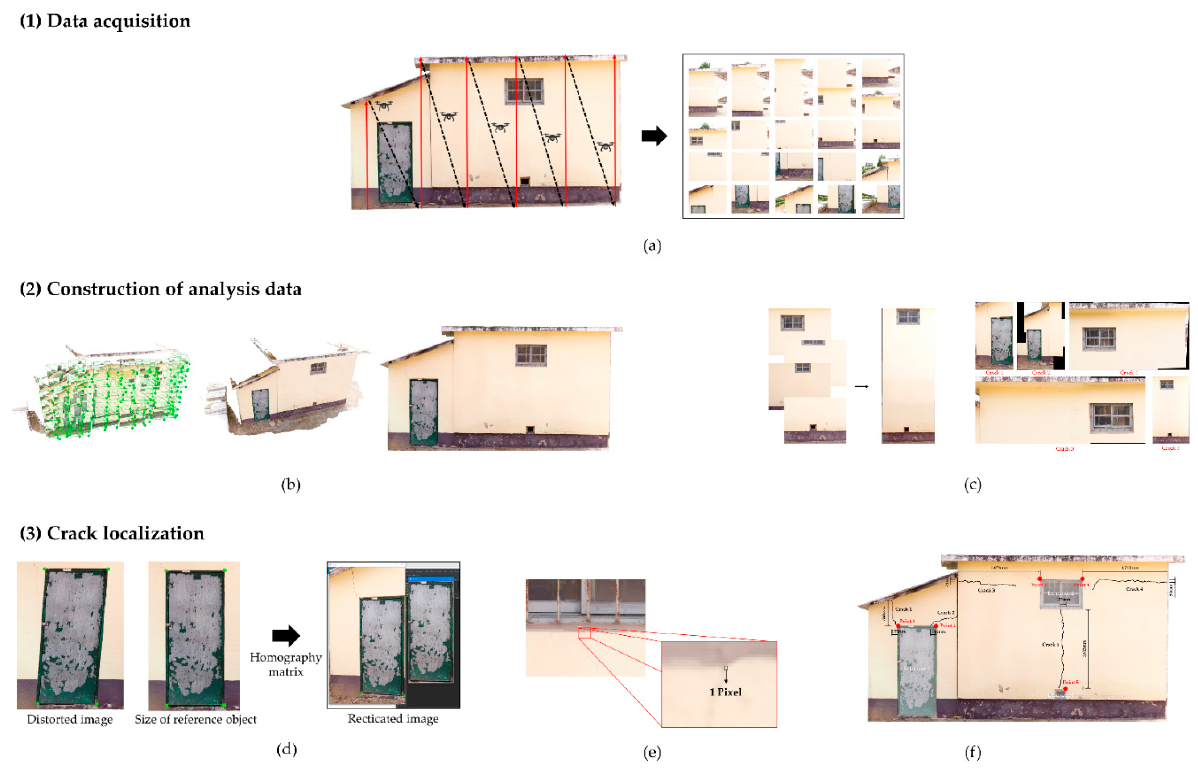
Figure 1. Overview of the UAV-based concrete crack localization: ( a ) Drone-based aerial